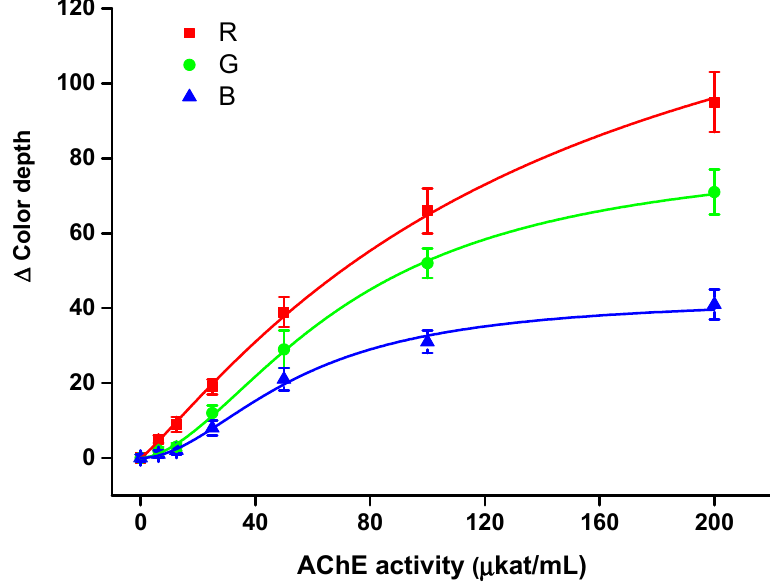
Figure 5. Calibration for acetylcholinesterase (AChE) using the smartphone camera-based colori- metric assay with the measuring pad modified with indoxylacetate. A 60 min incubation was cho- sen for this experiment. Standard error of the mean is expressed for five independent repeats. R red; G green; B blue.